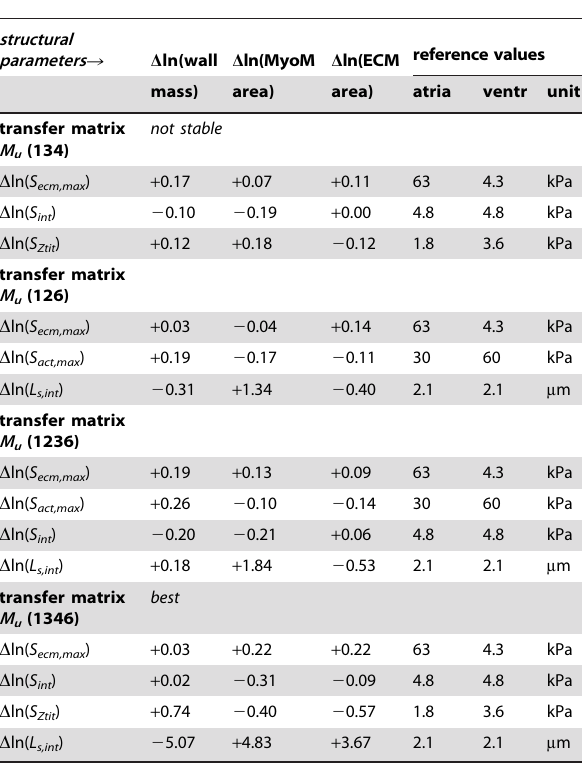
Table 4. Transfer coefficients from sensed variable to structural parameter.